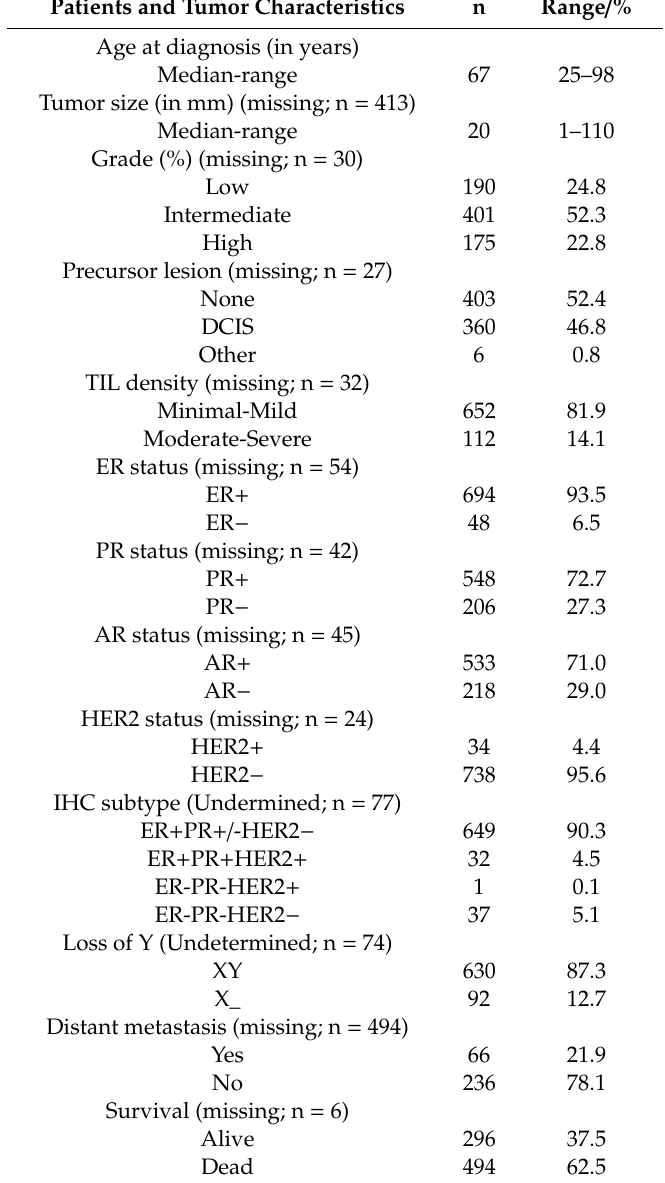
Table 1. Clinic pathological baseline characteristics (n = 796).